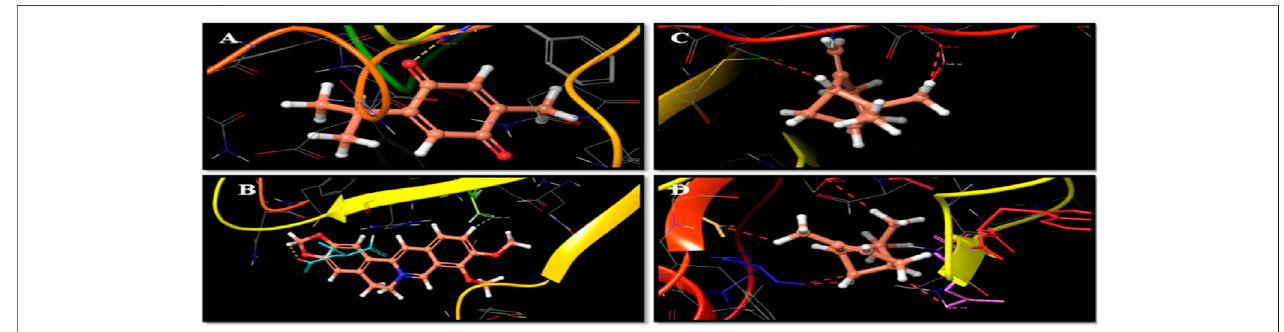
FIGURE 1 | (A) Thymoquinone and amino acid PHE 33 interactions. (B) Berberine, amino acid ASP 31, and hydrogen bond interactions. (C) β -Pinene interaction with amino acid cysteine. (D) α -Pinene interaction with amino aspartate.